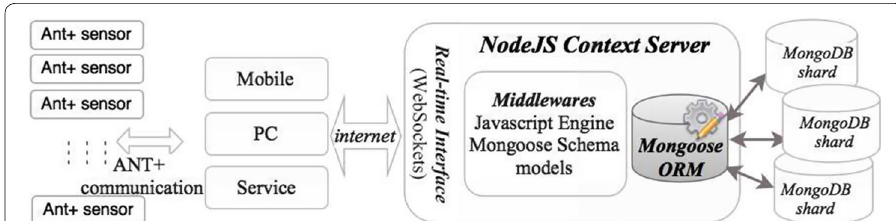
Fig. 4 MongoDB storage architecture: WebSockets based real-time interface with middlewares for JSON message processing, storage and evolution according to the schema model(s)